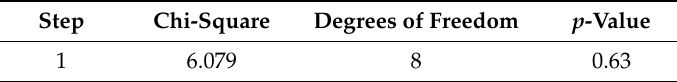
Table 3. The Hosmer-Lemeshow goodness of fit